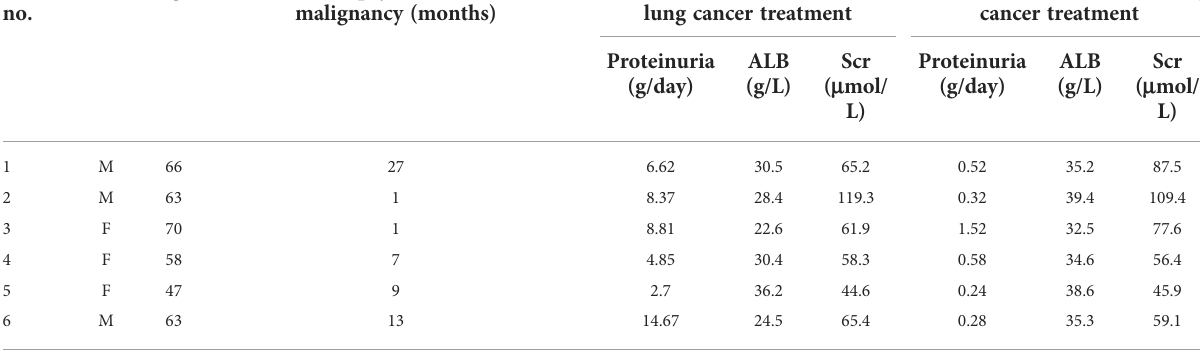
TABLE 5 Prognosis of lung cancer patients with nephropathy as the fi rst manifestation. Case